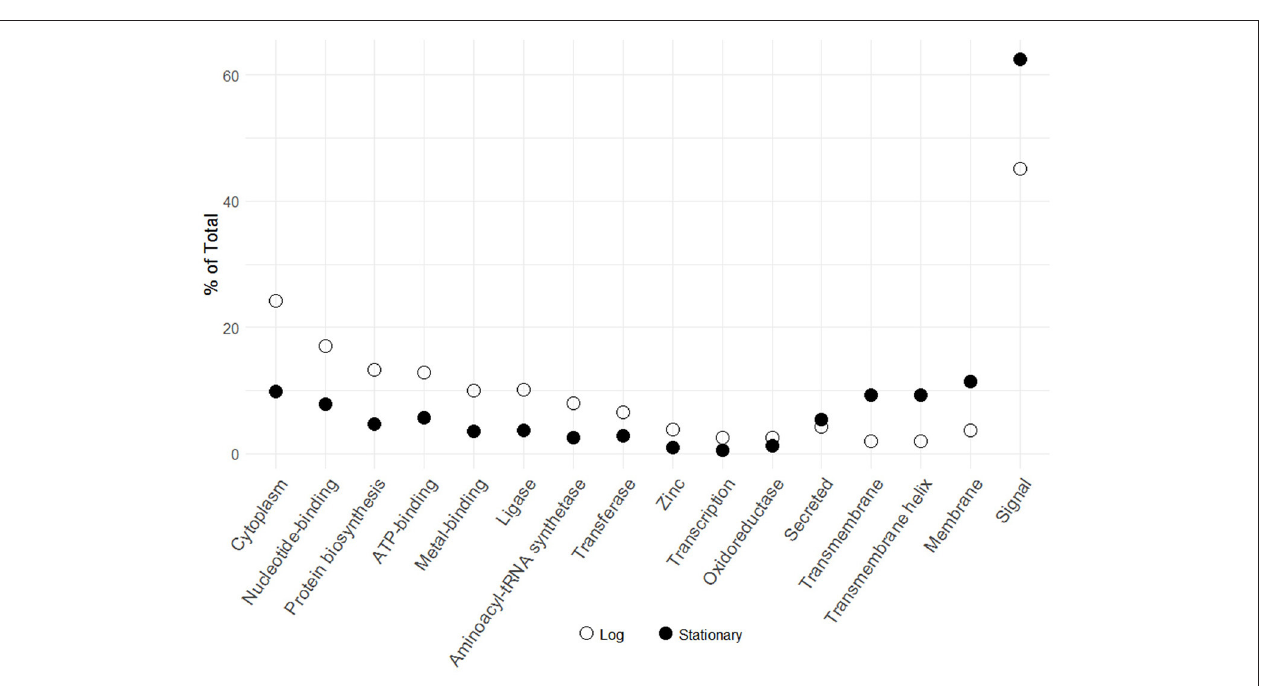
categories did not necessarily correlate with overall